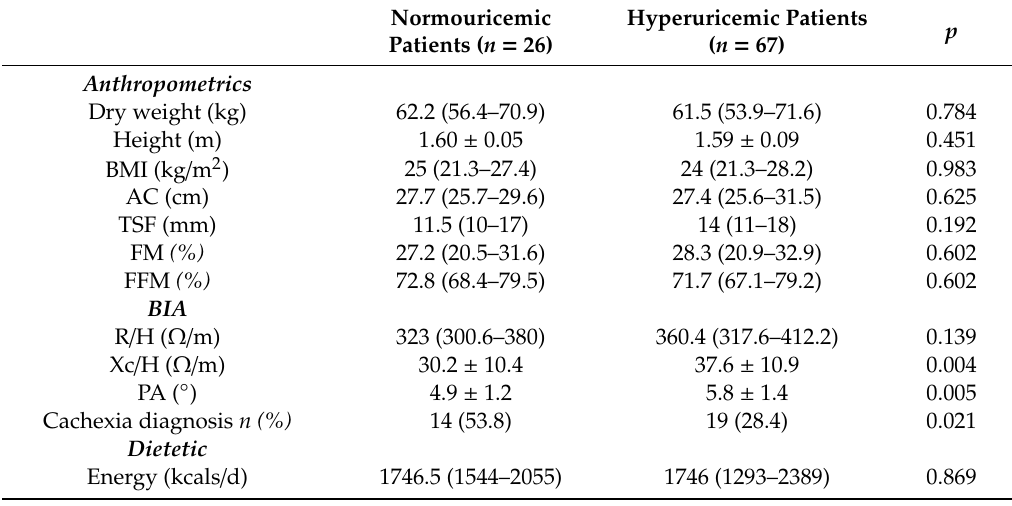
Table 4. Body composition and Dietary intake in normo and hyperuricemic patients on